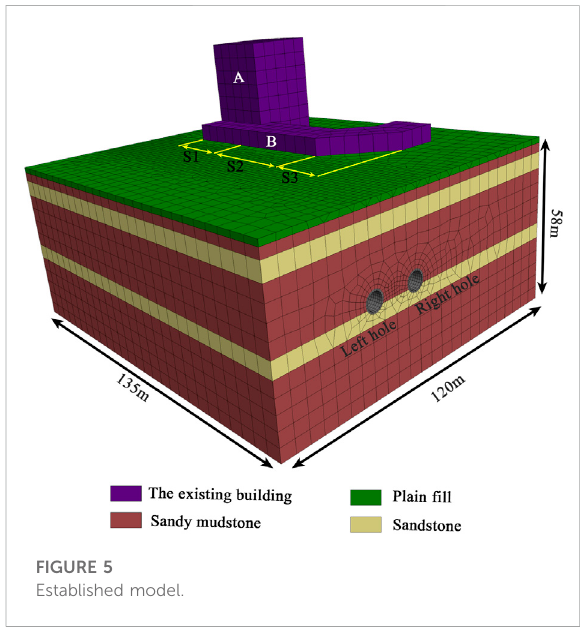
FIGURE 5 Established model.